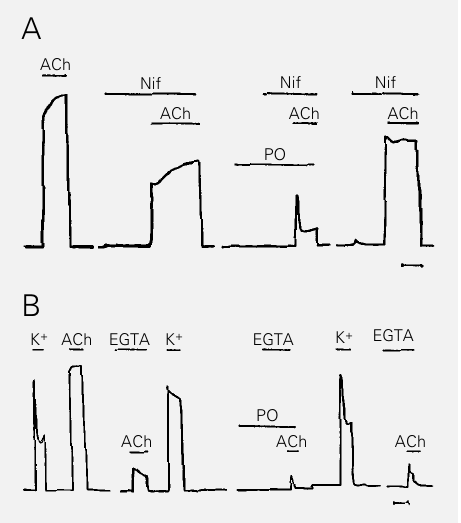
Figure 2 - Effect of piperitenone oxide (PO) on the components of acetylcholine (Ach) contrac- tion which is not blocked by ni- fedipine (Nif) or EGTA and Ca 2+ removal from the bath solution. A and B , Kymograph recording showing a typical experiment in which piperitenone oxide blocked the contraction pro- moted by ACh in the presence of nifedipine (A) or of EGTA and after Ca 2+ removal from the nu- trient solution (B). The nifedipine concentration (0.3 µg/ml) was enough to completely block the contraction induced by 60 mM K + . K + , 60 mM; Ach, 60 µM in A and B ; PO, 200 µg/ml; EGTA, 0.2 mM. Horizontal bars above the recording indicate when the preparation was exposed to the substance or ionic species; the kymograph was stopped during the application of EGTA or ni- fedipine and during the first four subsequent minutes. Same horizontal calibration for all trac- ings (1